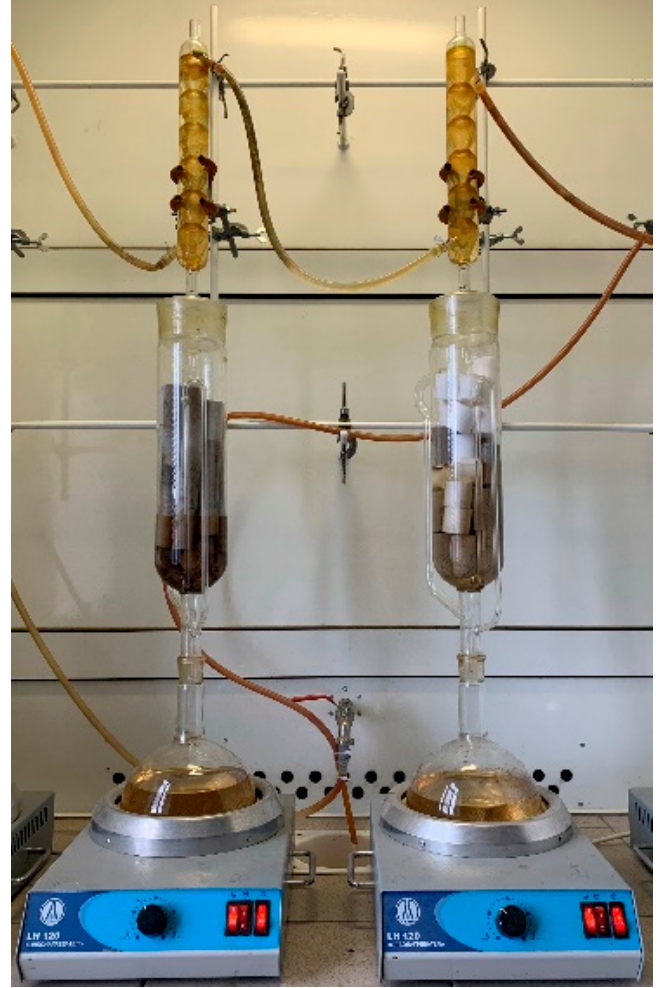
Figure 3. Extraction of hydrocarbons from prepared carbonate rock samples.